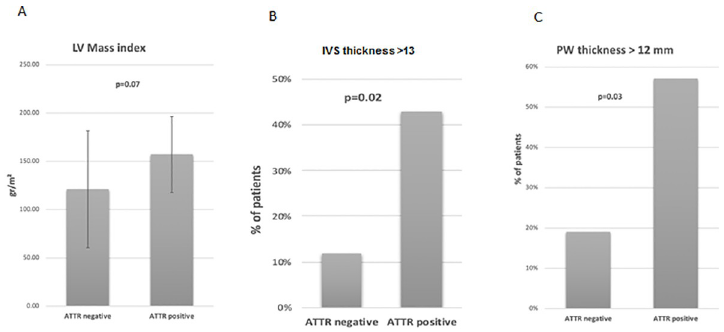
Fig 2. Comparison of patients’ left ventricular mass index (LVMi), interventricular septum (IVS) thickness, and posterior wall (PW) thickness. A. Left Ventricular Mass index (gr/m 2 ). B. Interventricular Septum Thickness > 13 mm (%). C. Posterior Wall Thickness > 12 mm